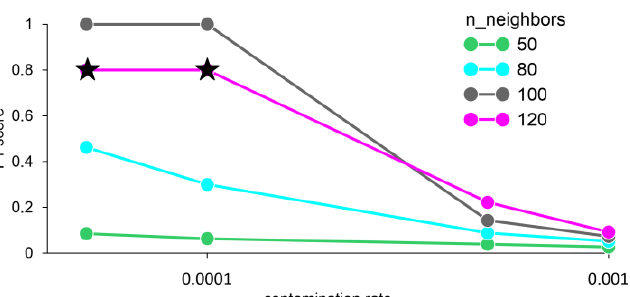
Figure 8. F1 score for different n_neighbors and averaging data for 1 min, obtained by the LOF method. Stars — FN error (false negative).